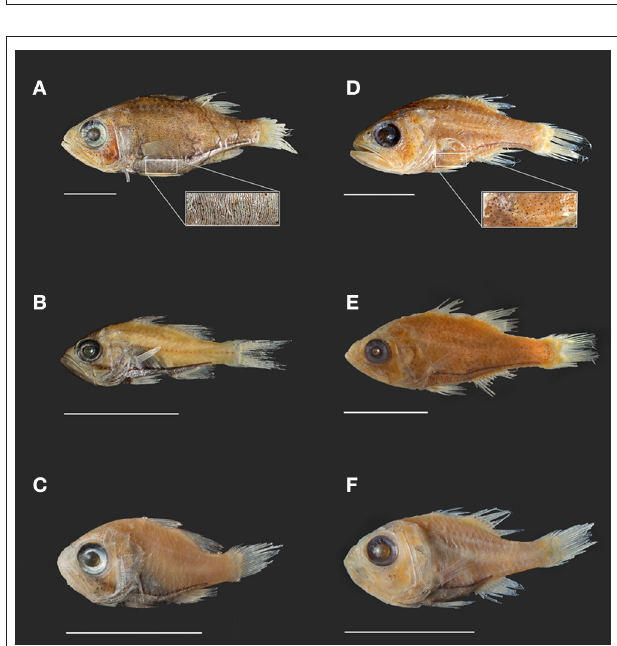
FIGURE 2 | Photographs of select Siphamia specimens from lots used in this study. Specimens (A–C) represent the tubifer subgroup (Gon and Allen, 2012), identified by the striated light organ (A) and specimens (D–F) represent the tubulata subgroup, identified by the spotted light organ (D) . (A) S. tubifer (USNM341595) with insert of light organ detail showing striated morphology. (B) S. stenotes (USNM396981, paratype). (C) S. jebbi (CAS223855). (D) S. tubulata (CAS28515) with insert of light organ detail showing spotted morphology. (E) S. corallicola (USNM203781). (F) S. brevilux (CAS65338, paratype). Scale bars indicate 1cm in